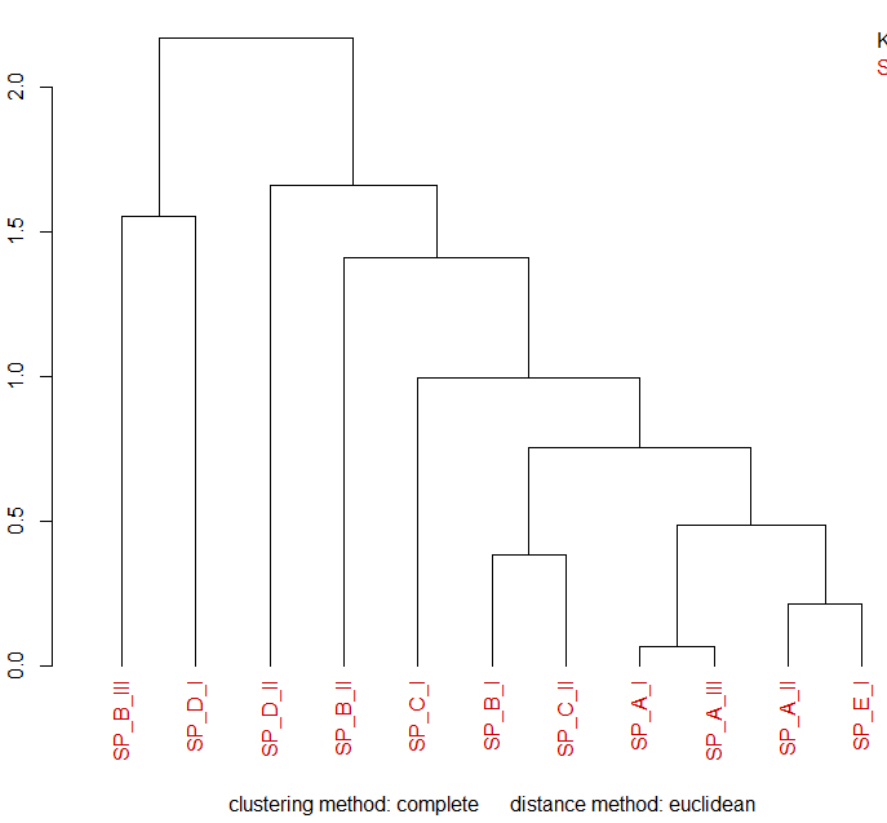
Figure 4. An hierarchical cluster analysis (HCA) plot of the chromatographic data, where the SP prefix denotes “ sample ” followed by the label.